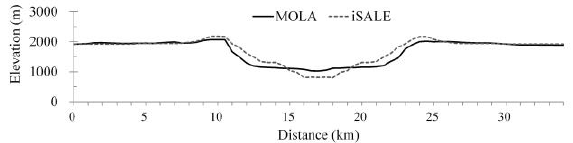
Figure 5. Profiles of the crater final stage (iSALE 2D) compared to the MOLA data